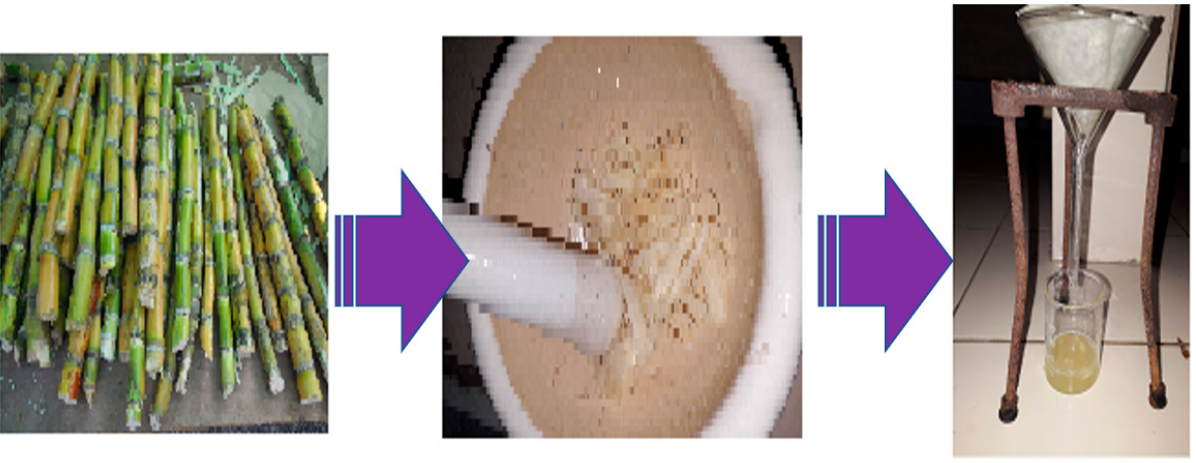
Figure 1. Pictorial presentation of extraction of sugarcane extract from